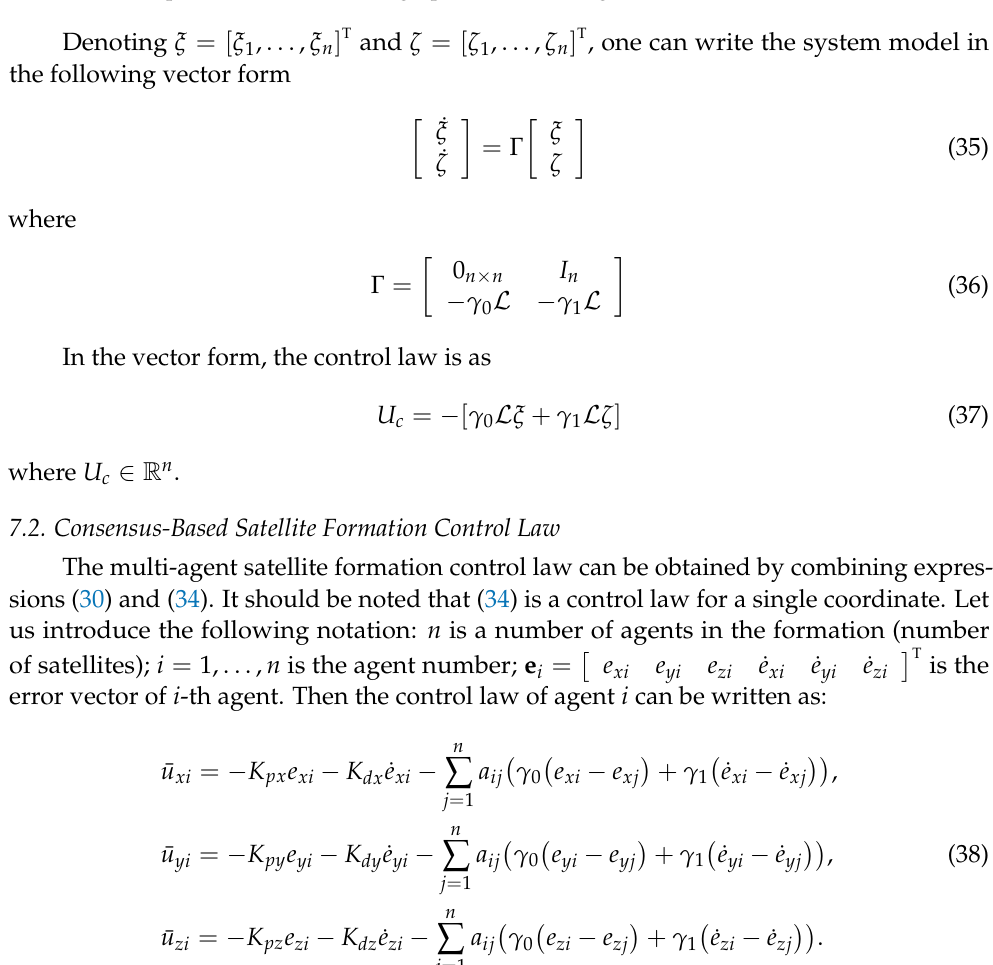
Figure 3. Examples of communication graphs of 8 and 12